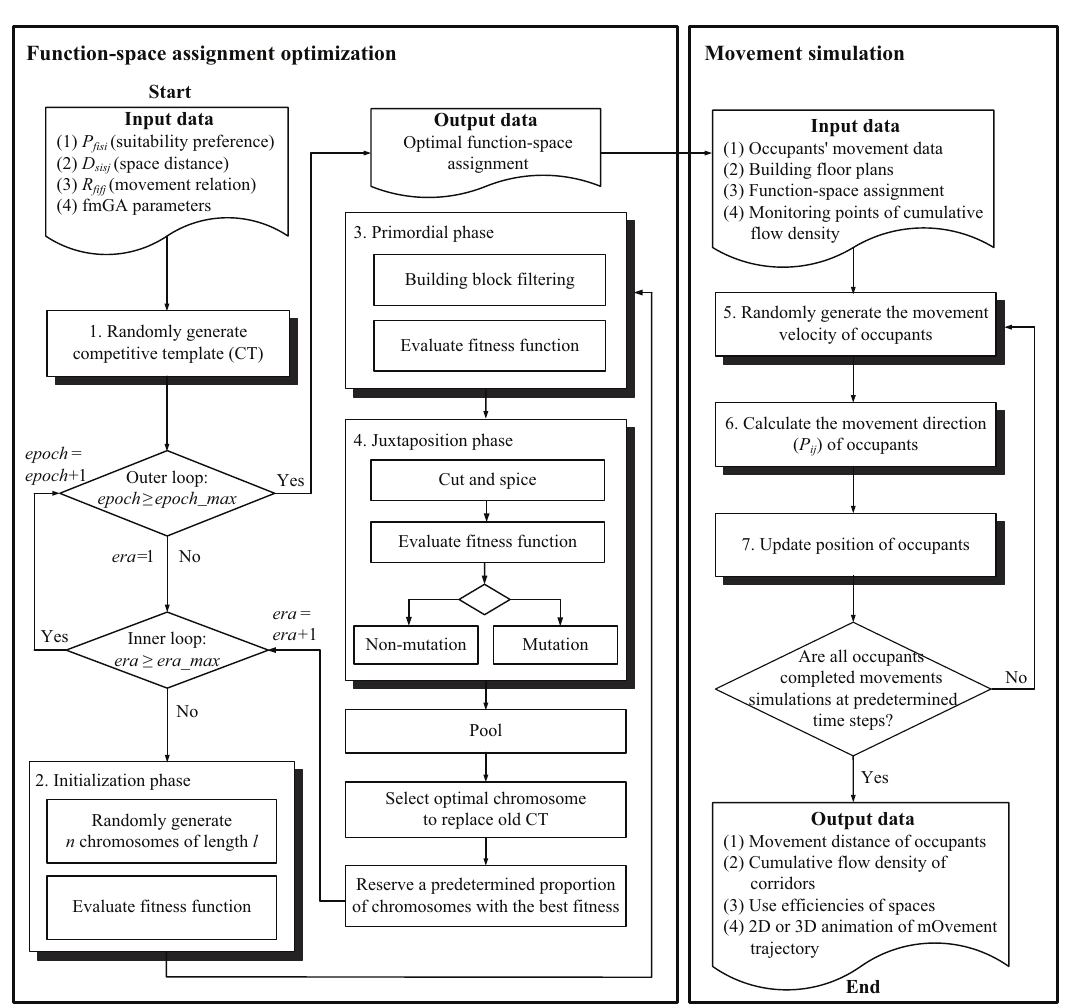
Fig. 6. Problem-solving process for function-space assignment optimization and movement